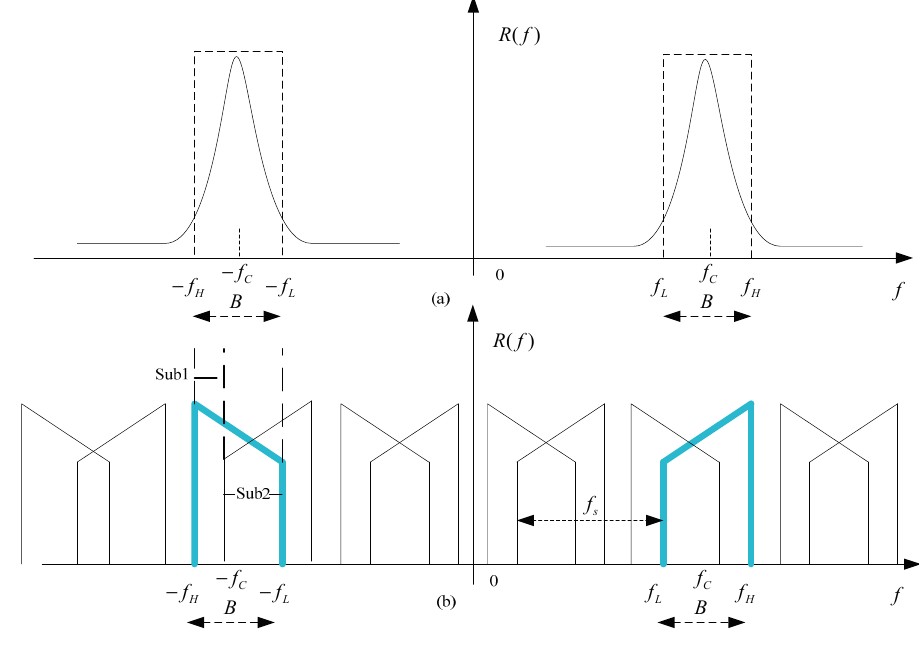
Figure 3. ( a ) The original blade vibration signal; ( b ) The spectrum of one sample stream of the non-uniform